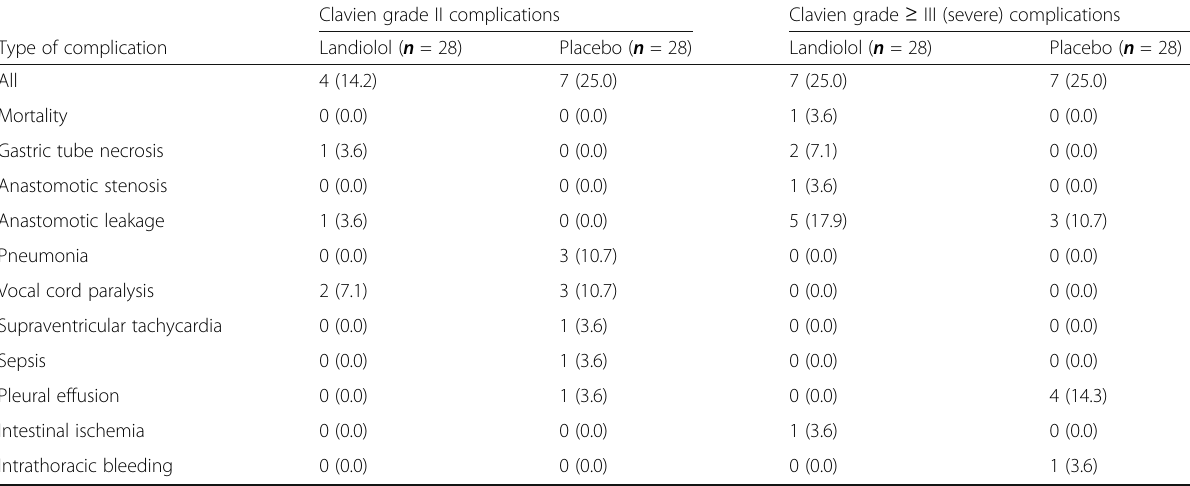
Table 3 Details of all complications in landiolol and placebo groups Clavien grade II